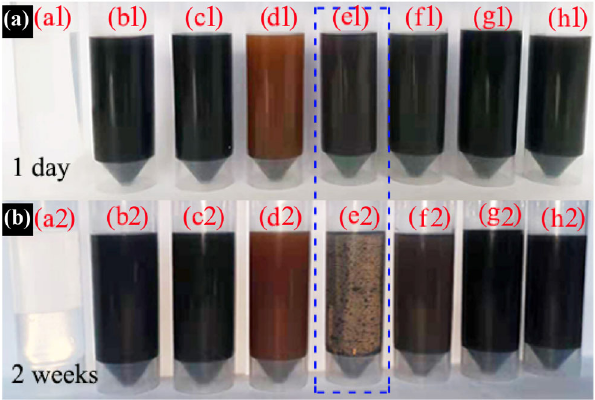
Fig. 4 Digital images of (a1, a2) PAG base oil and PAG with